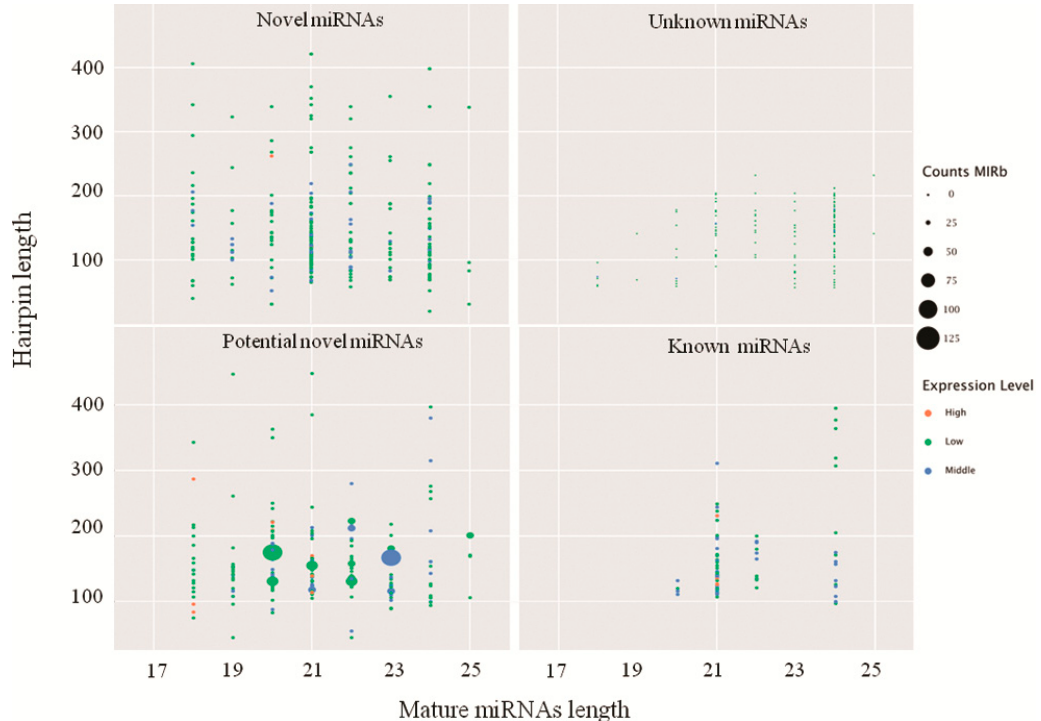
Figure 1. The four indicated groups of miRNAs identified from an incompatible interaction. CountsMIRb, the counts of miRNAs from miRBase. Expression level, low indicates <10, middle indicates >10 but less than average, high indicates over average. Int. J. Mol. Sci. 2019 , 20 , x FOR PEER REVIEW